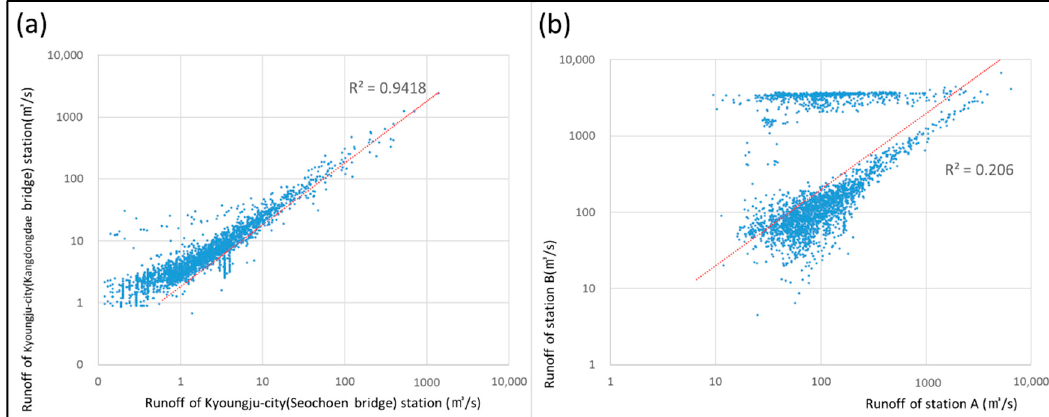
Figure 4. Scatter plot of historical daily runoff record (2012 to 2019): ( a ) scatter plot of runoff in the Hyeongsan River (Seochoen bridge and Kangdong large bridge at Gyeongju City in Figure 1), ( b ) scatter plot of stations A and B in the Nakdong River.